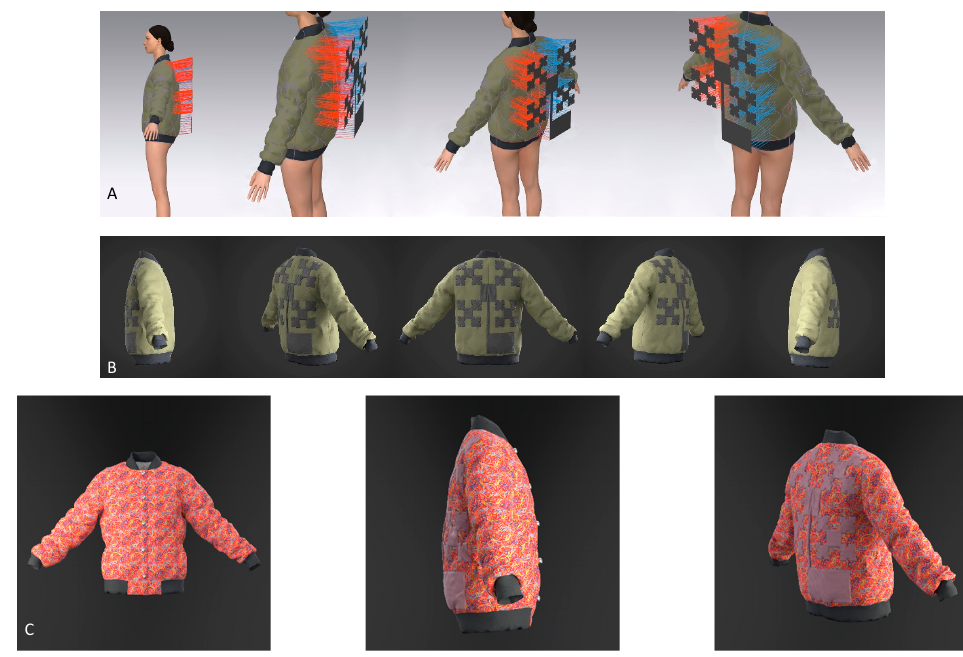
Figure 7. Α third-order Minkowski fractal antenna integrated into a women’s bomber jacket.